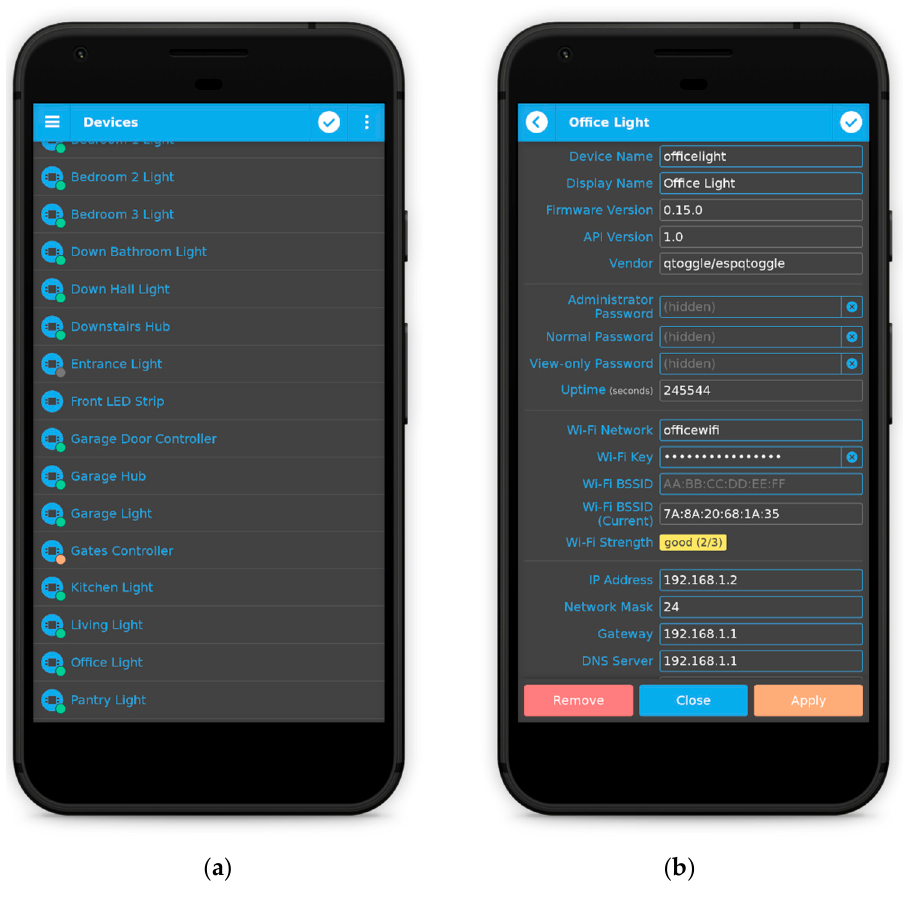
Figure 7. Adding, removing ( a ) and configuring slave devices ( b ).